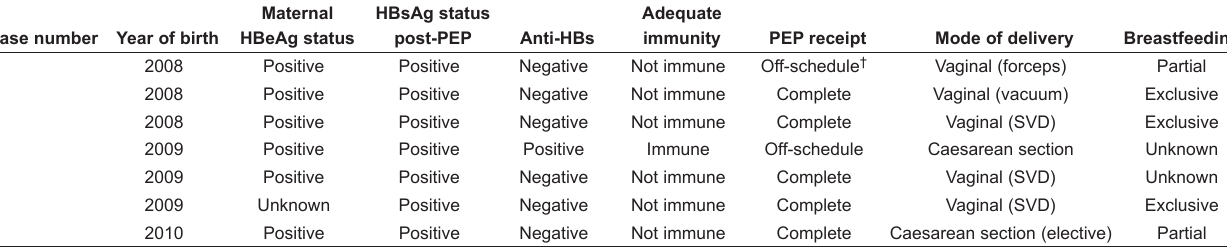
Table 4 Virology and delivery characteristics of hepatitis b surface antigen (Hbsag)-positive infants (n=7) Case number Year of birth